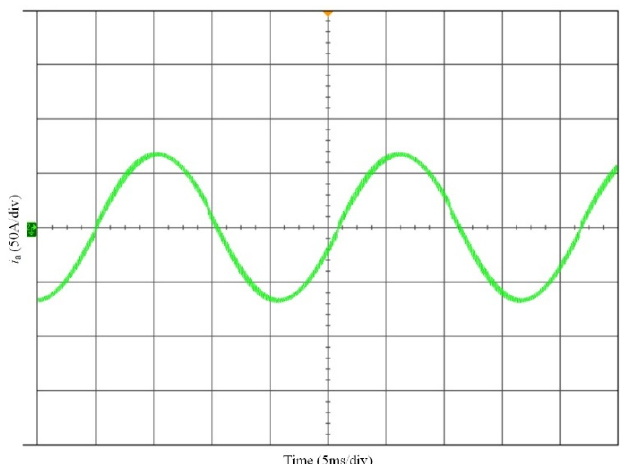
Figure 12. The curve of phase current for the conventional MPDTC.